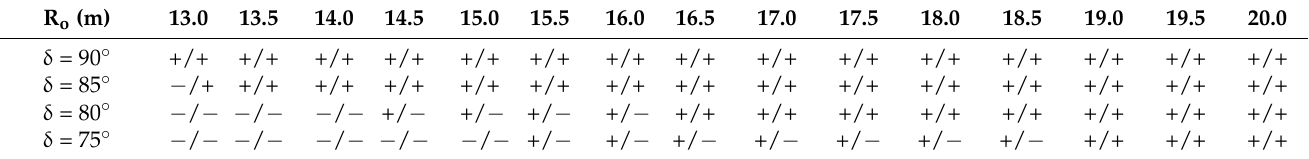
Table 3. Overview of two roundabout design conditions’ fulfillment (marked with +): Condition 1 (l ≥ 20 m)/Condition 2 (R j+1 ≥ R j + 2 m).